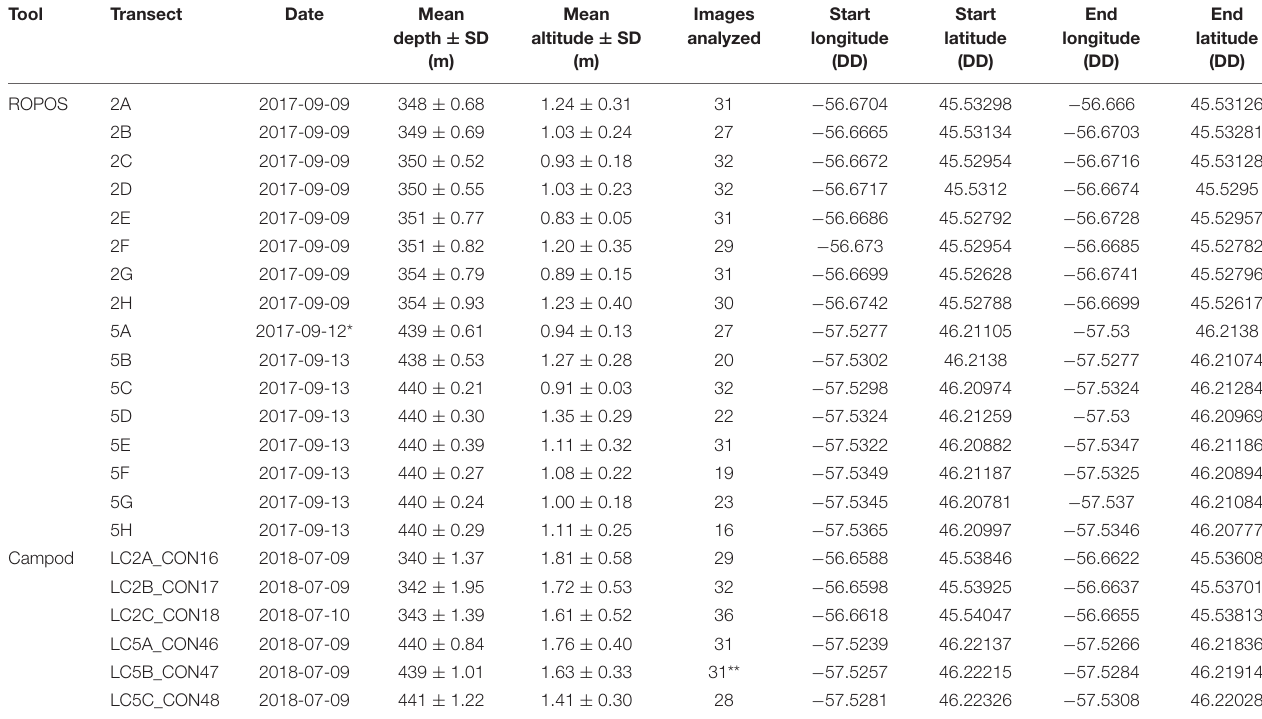
TABLE 2 | Summary of imagery transect metadata at stations LC2 and LC5 in the Laurentian Channel MPA. DD: decimal degrees. Tool